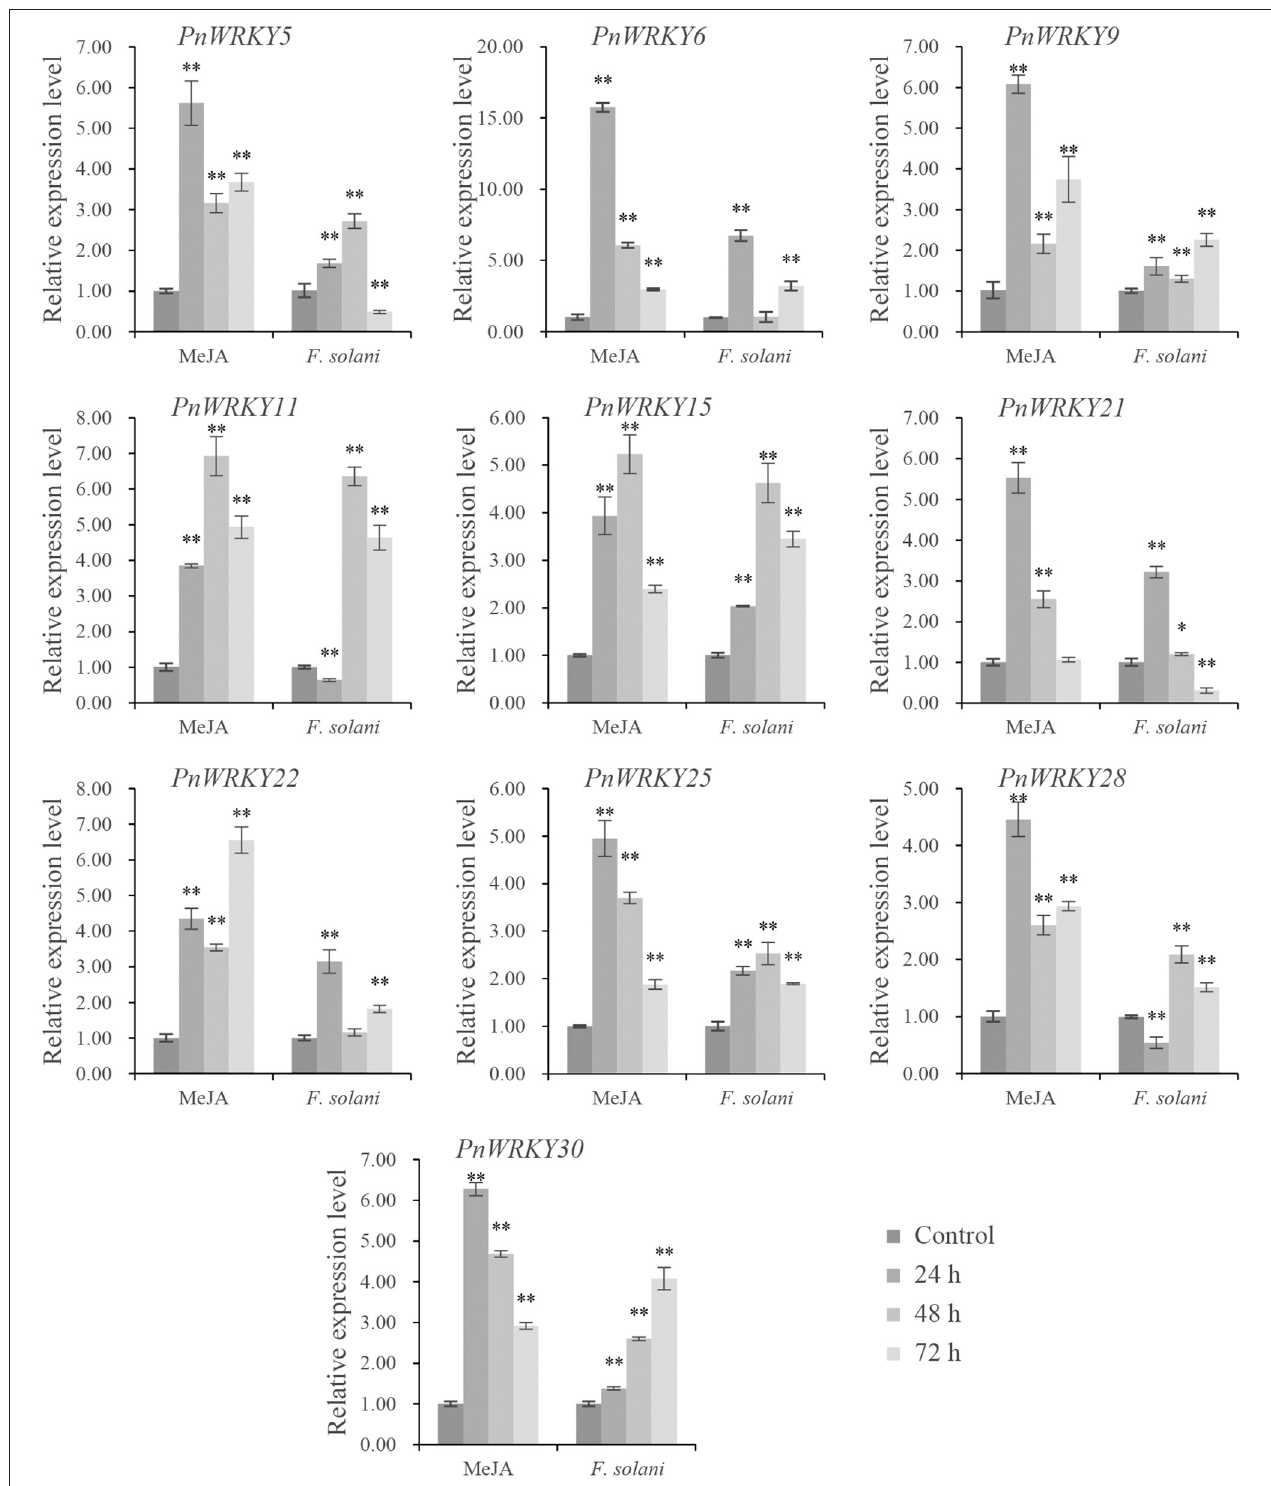
FIGURE 2 | The expression levels of PnWRKYs during independent MeJA treatment or Fusarium solani infection. P. notoginseng roots were treated with MeJA and inoculated with F. solani , respectively. The roots were collected after treatment or inoculation for 24, 48, and 72h. P. notoginseng roots treated with sterile water for 30min were harvested as control. The 2 − 11 Ct method and t test (* p < 0.05, ** p < 0.01) were used to calculate the relative gene expression levels and statistical difference.